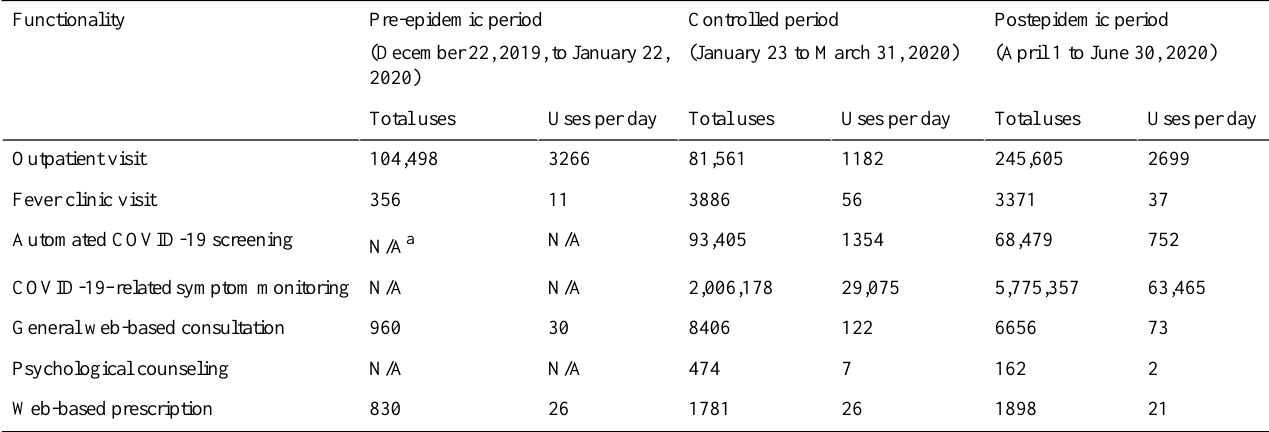
Table 1. Hospital outpatient service volumes and platform service usage data by functionality in the pre-epidemic, controlled, and postepidemic